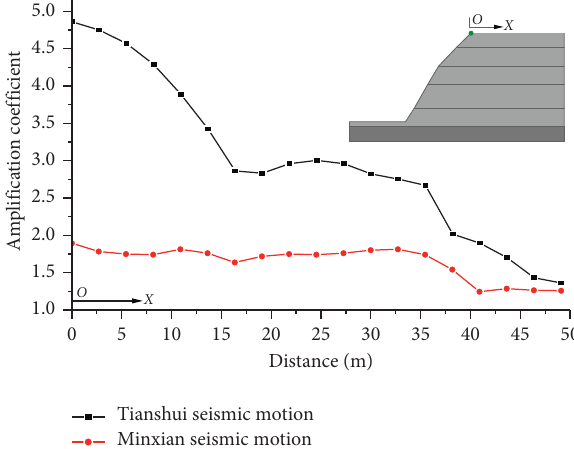
Figure 12: Distribution of the amplification coefficient with dis- tance on the top of the loess